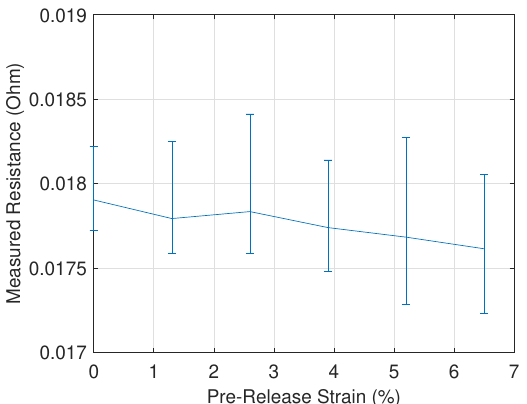
Figure 6. Measured resistance values on strips of M270-35A that underwent increasing levels of plastic deformation. Each measurement was repeated 5 times and the resulting error bars are